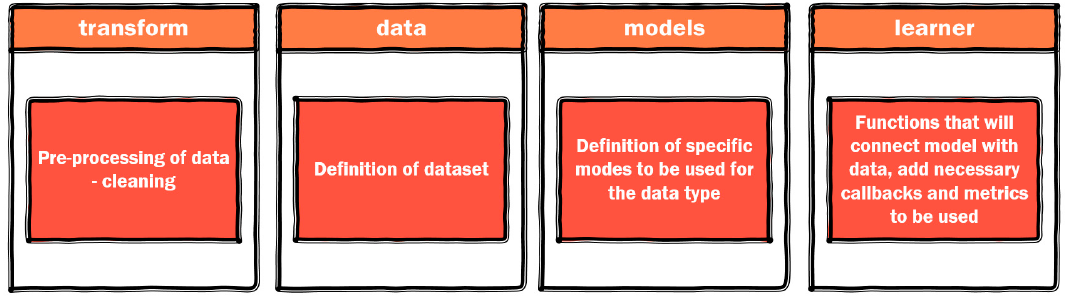
Figure 3. FastAI tabular module structure.